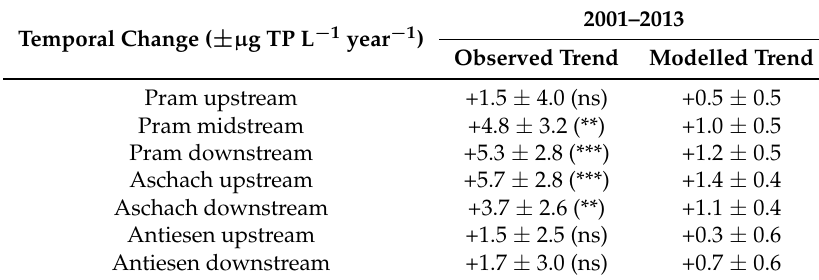
Table 1. Comparison of observed and modelled yearly changes of total phosphorus (TP) concentration in the sub-catchments of the rivers Pram, Aschach and Antiesen for the period 2001–2013. Statistical significance of observed trends: ns (non significant), * (significant), ** (very significant), *** (highly significant). Uncertainty of observed trends calculated through Theil–Sen estimator method in R [29]; uncertainty of modelled trends calculated through two MONERIS scenarios, obtained by altering the relative importance of erosion, groundwater and WWTP emissions